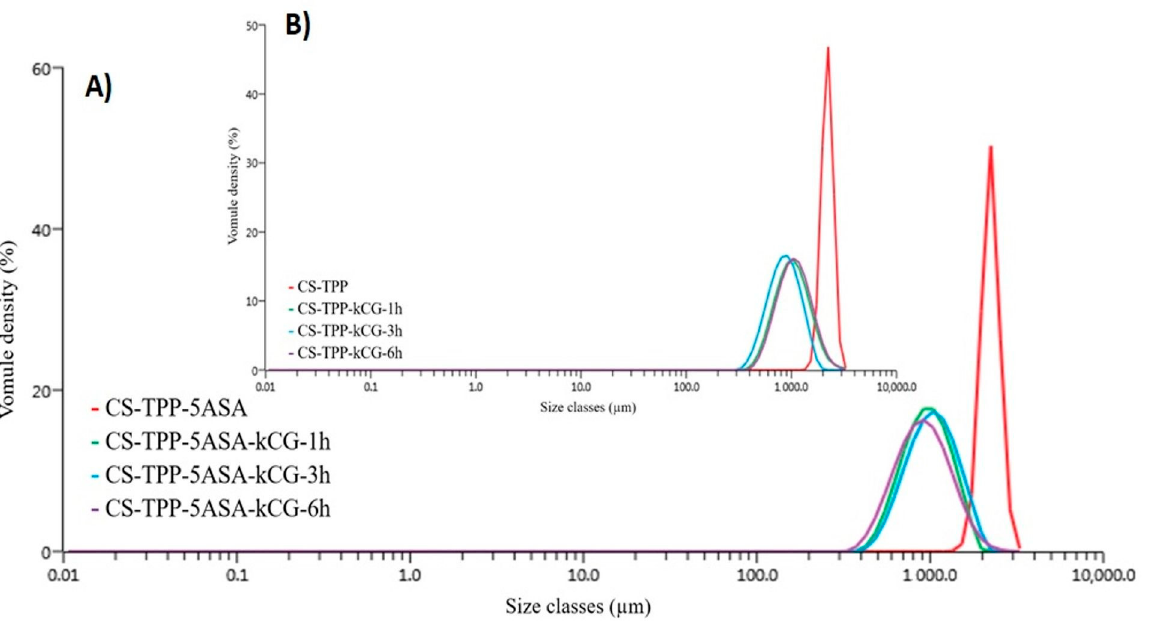
Figure 8. Volume-based particle distribution of CS-TPP-kCG loaded with 5ASA and blank.